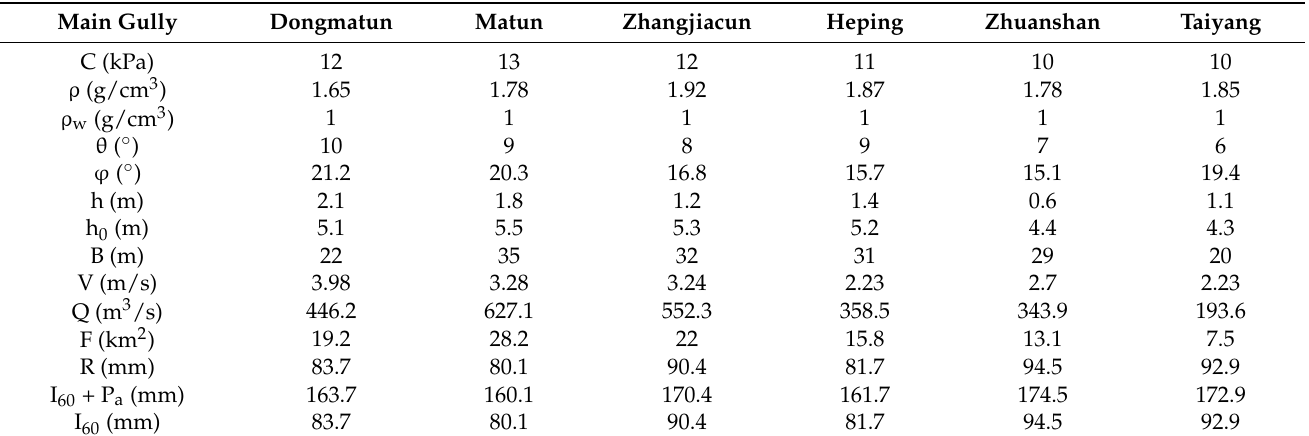
Table 8. Prediction results of critical rainfall of the debris flow gully in the Laomao Mountain area based on the HIMM